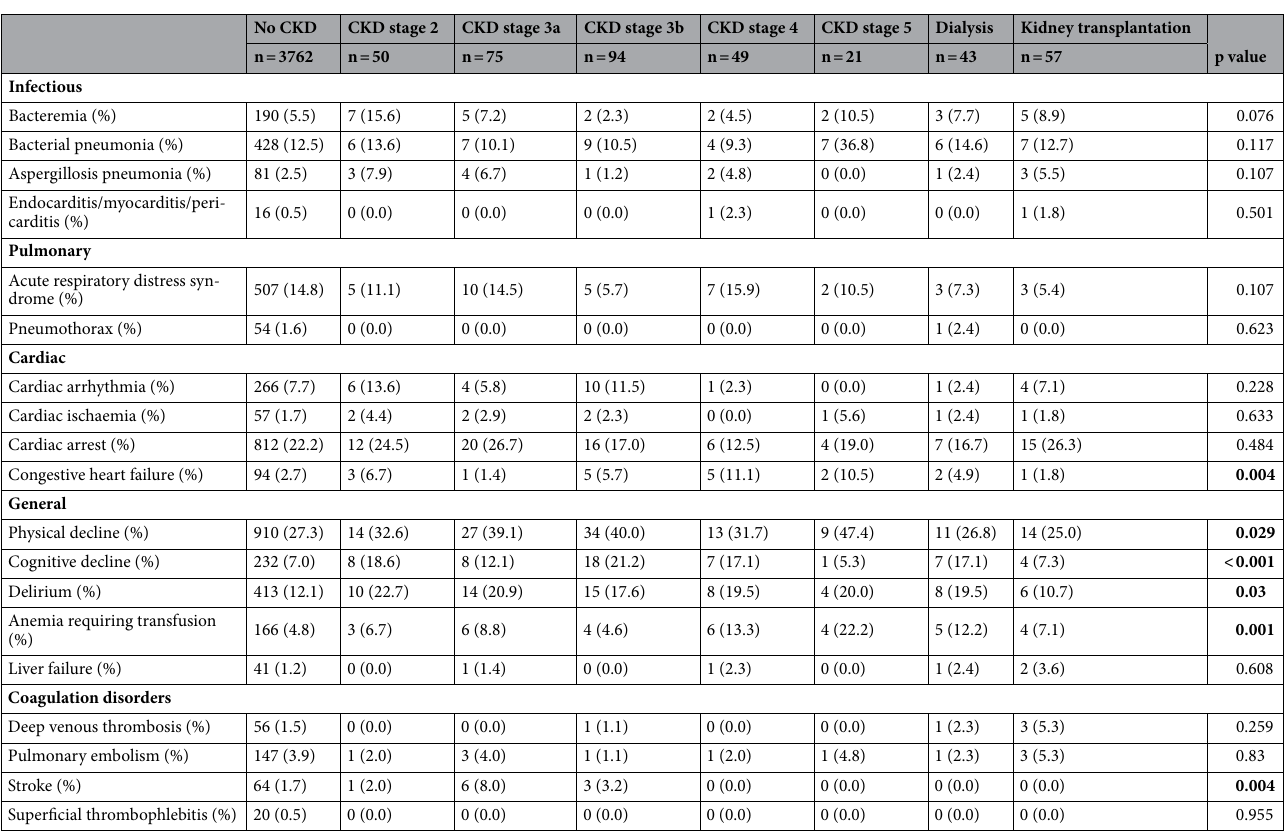
Table 3. Complications among chronic kidney disease groups during hospitalization for COVID-19. Significant values are in bold. Continuous data presented as median [interquartile range], categorical in numbers (%). Continuous variables were compared using the Kruskal–Wallis test, with pairwise Wilcoxon rank tests between No CKD and the corresponding CKD group (Benjamini–Hochberg false-discovery rate adjusted) if overall significant. Significant pairs are denoted with “*”. For categorical data we used the Fisher exact test to compare group differences, with pairwise posthoc tests (BH adjusted) between No CKD and the corresponding CKD group if overall significant. All pairs differed significantly in eGFR, not denoted with capitals for readability. P is considered significant at P ≤ 0.05. CKD stage 2 = eGFR 60–89 ml/min/1.73 m 2 ,